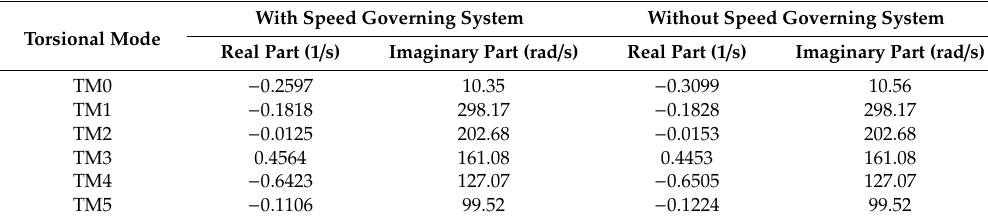
Table 5. Eigenvalues with and without speed governing system.